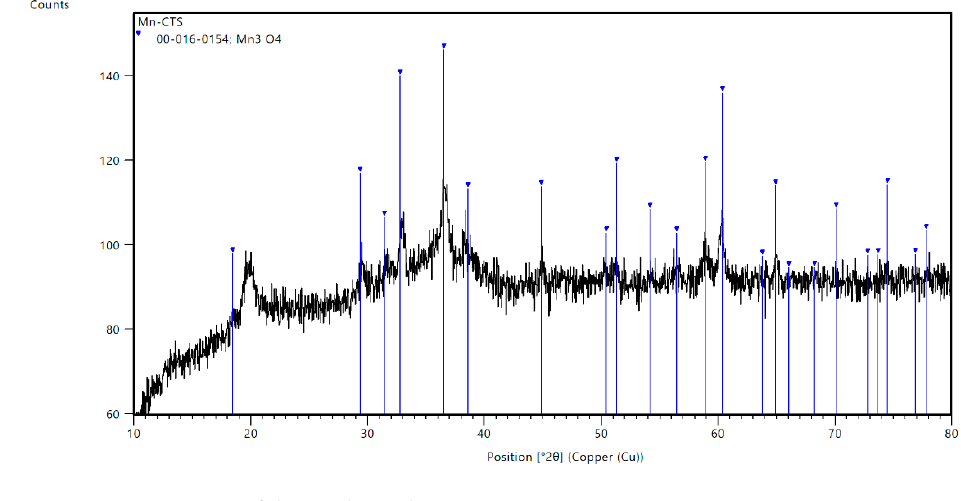
Figure 2. XRD pattern of the Mn-biosorbent.